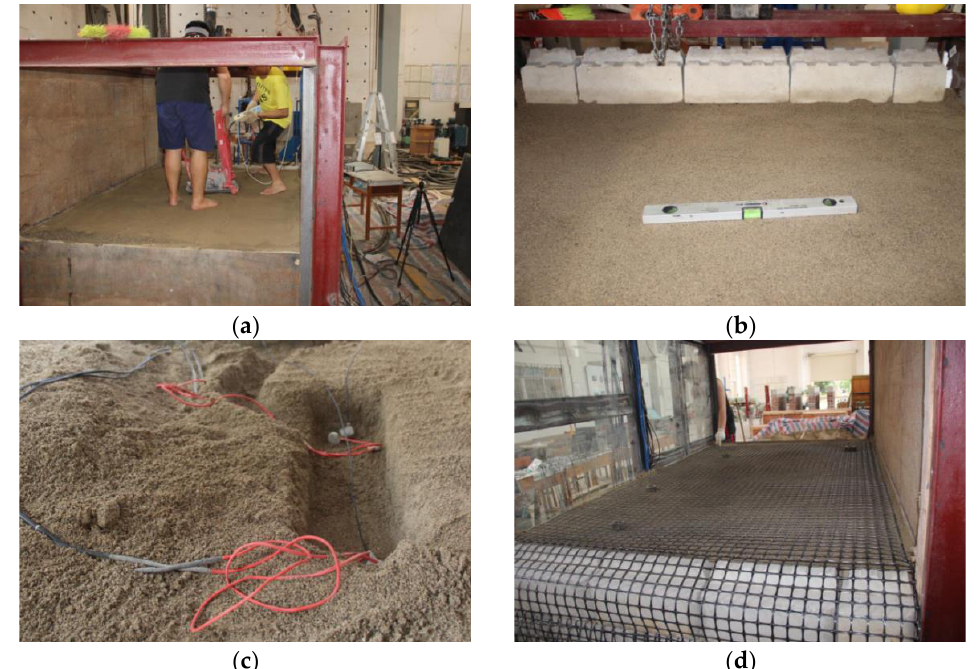
Figure 3. Filling process: ( a ) tamped backfill; ( b ) flattening; ( c ) burying measuring elements; ( d ) laying geogrid.